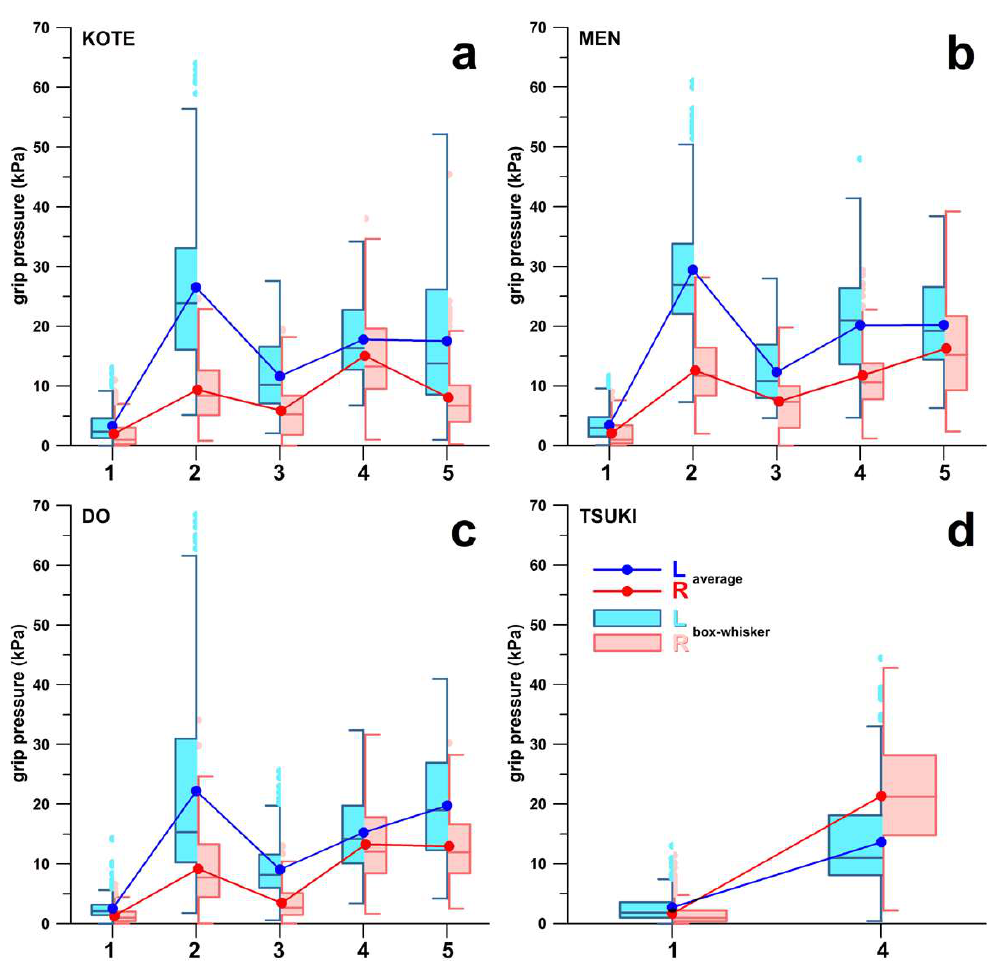
Figure 4. Example of grip pressure profile (pressure vs. time) of a participant hitting four different targets ( a ) Kote-bu, ( b ) Men-bu, ( c ) Do-bu, and ( d ) Tsuki-bu measured by the Smart Shinai; L = left hand, R = right hand, D = pressure differential (L–R); 1–5: attack phases; 1 = Kamae, 2 = Seme, 3 = Toraeru, 4 = Datotsu, 5 = Zanshin.